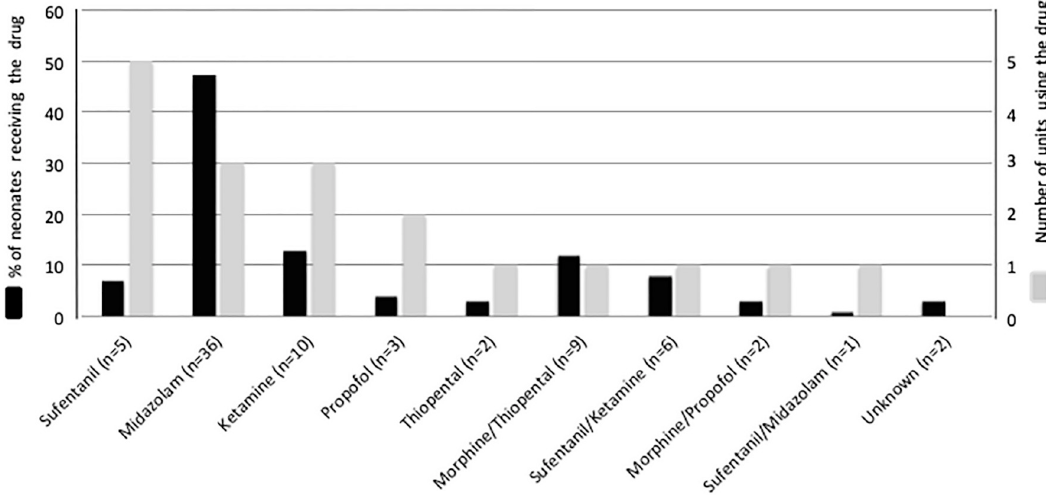
Fig 3. Drug(s) regimens used for premedication before tracheal intubation in the delivery room. The X axis includes all used premedication regimens with the number of patients in parenthesis. The black bars indicate the percentage of infants who received each drug or drugs combination within the premedicated group. The corresponding Y-axis is on the left side of the graph. The grey bars indicate the number of centers that used each drug or drugs combination at least once. The corresponding Y-axis is on the right side of the